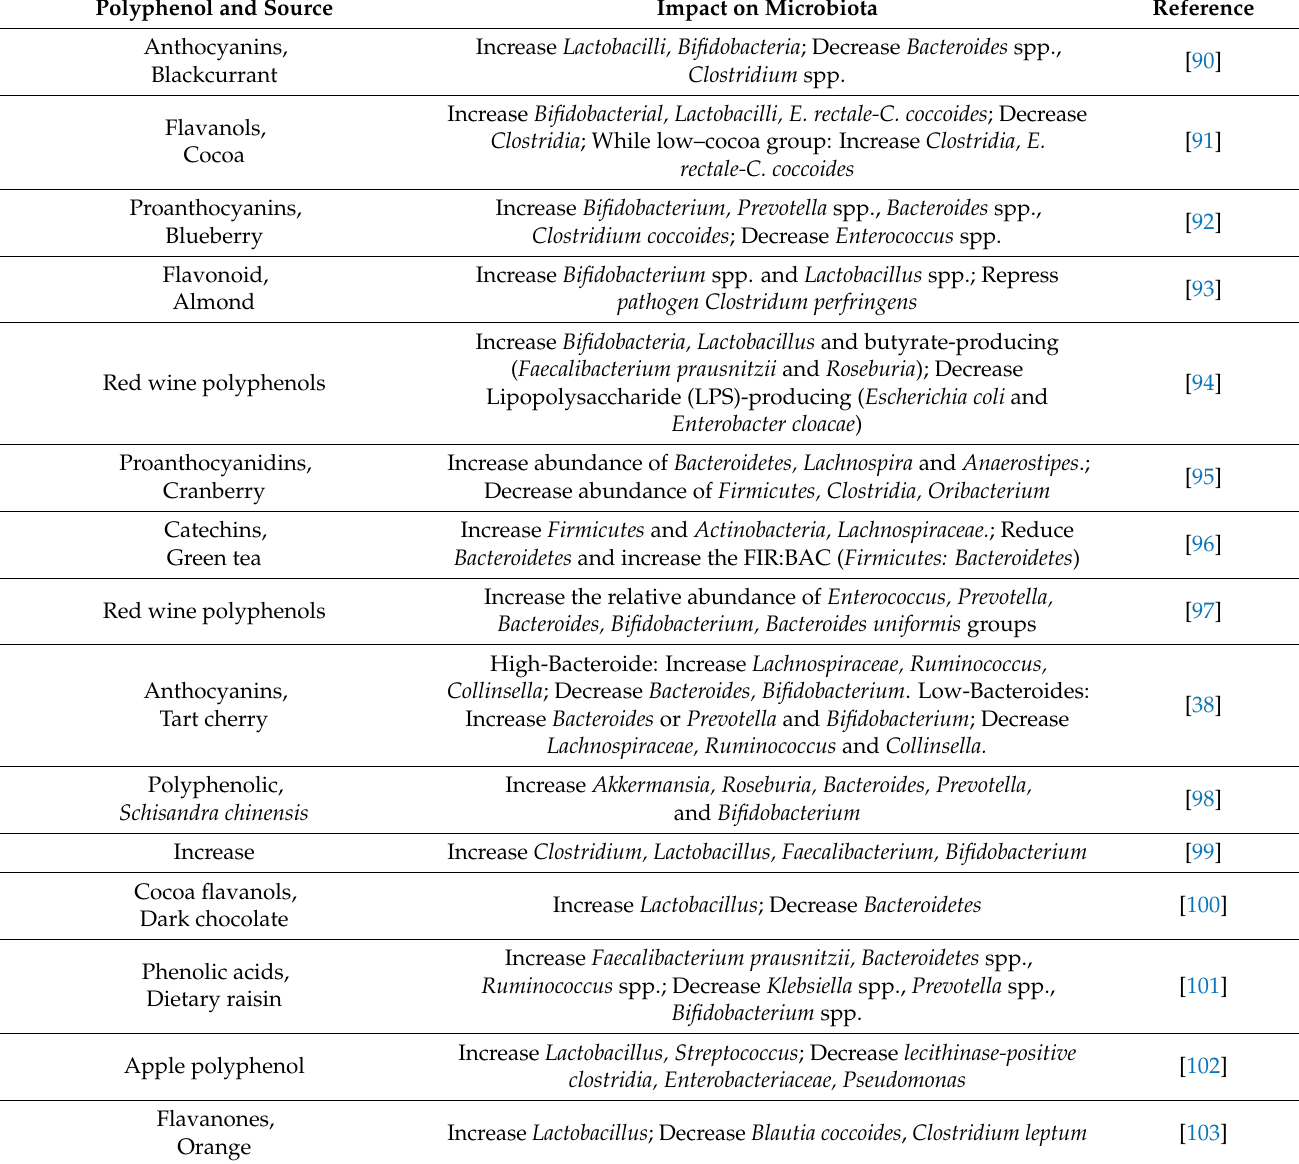
Table 3. Effect of polyphenols on human gut